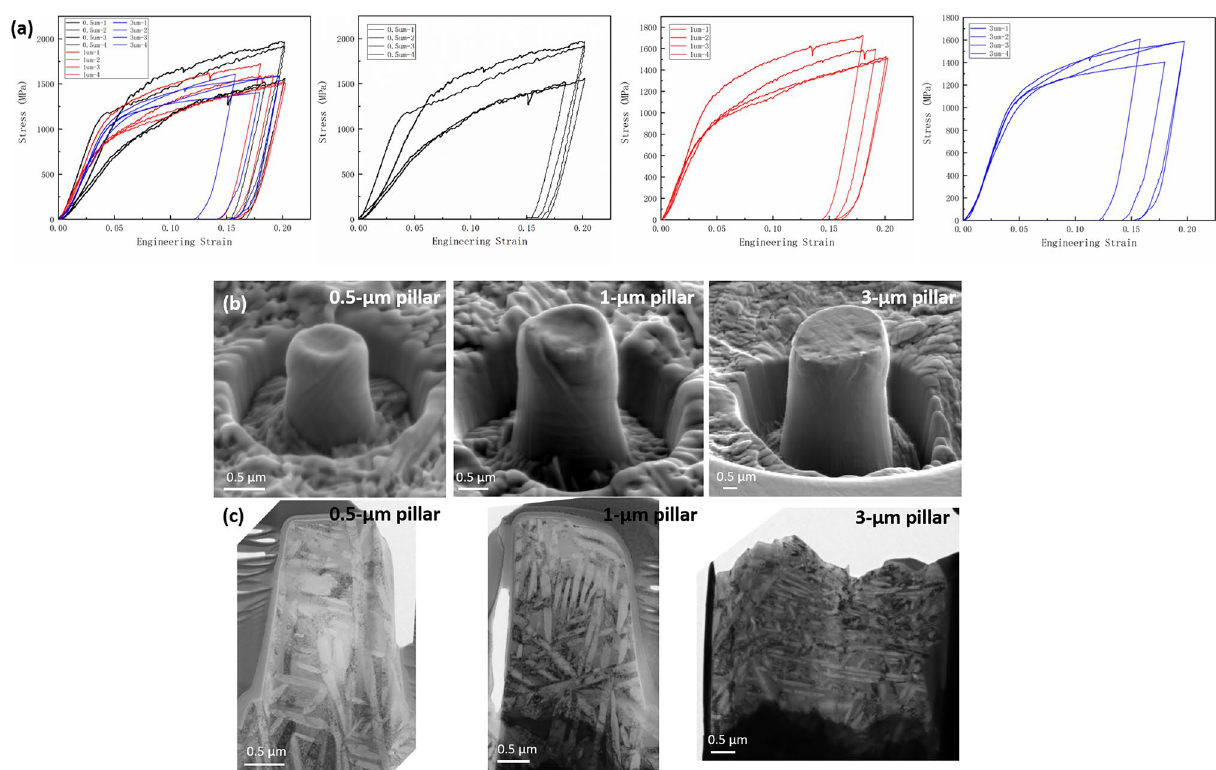
Figure 4. Mechanical properties of TiMo micro-pillars with different sizes. ( a ) Stress–strain curves of micro- pillars with diameter of 0.5 μm, 1 μm, and 3 μm. ( b ) SEM images for three sized micro-pillars after compression, all pillars deformed uniformly. ( c ) Cross-section TEM images for the micro-pillars with different sizes after